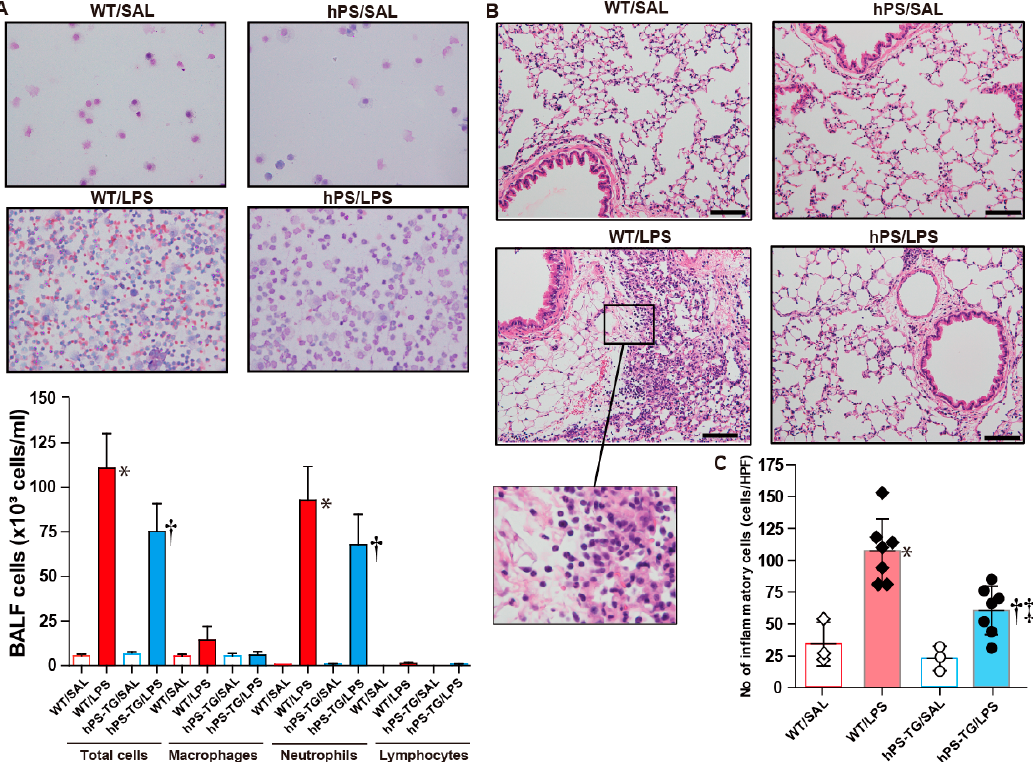
Figure 2. Less lung cell infiltration in mice overexpressing hPS. Mice were allocated in four groups including wild type mice treated with saline (WT/SAL, n = 3) or LPS (WT/LPS, n = 7), and human PS transgenic (TG) mice treated with saline (hPS TG/SAL, n = 3) or LPS (hPS TG/LPS, n = 7). Cells in bronchoalveolar lavage fluid were counted using automatic cell counter and stained for differential counting ( A ). Lung tissue samples were stained with hematoxylin & eosin ( B ). The number of cells was counted using the WindROOF image processing software ( C ). Scale bars indicate 100 µm. Data are expressed as the mean ± SD. * p < 0.05: WT/LPS vs WT/SAL; † p < 0.05: hPS-TG/LPS vs hPS-TG/SAL; ‡ p < 0.05: hPS-TG/LPS vs WT/LPS.